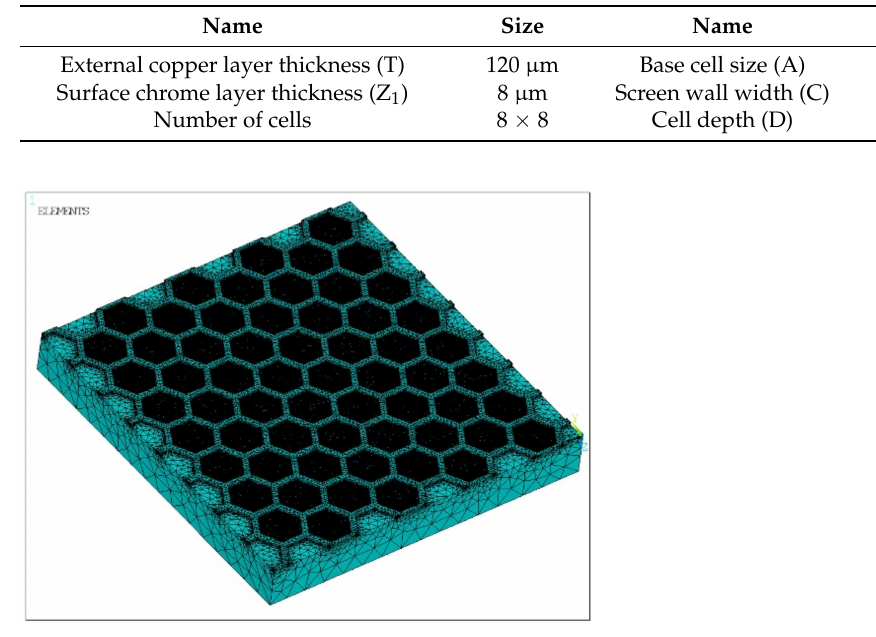
Figure 4. Regular hexagonal cell microstructure after